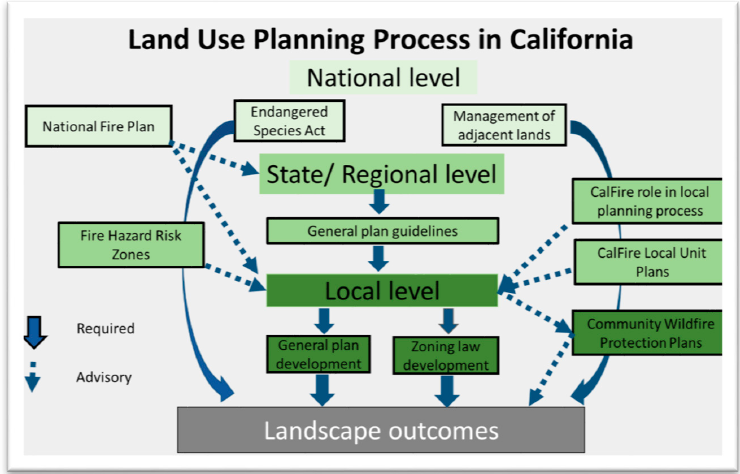
Figure 5. Schematic of land use planning for wildfire in California. The federal government has limited influence on landscape outcomes, primarily through the allocation of fire funding and through programs that were not intended as tools to mitigate fire risk, such as the Endangered Species Act, and management of adjacent lands. The state government establishes local planning rules and has an important advisory role for local government. Local planning laws, general plans and zoning ordinances, have direct impacts on landscape